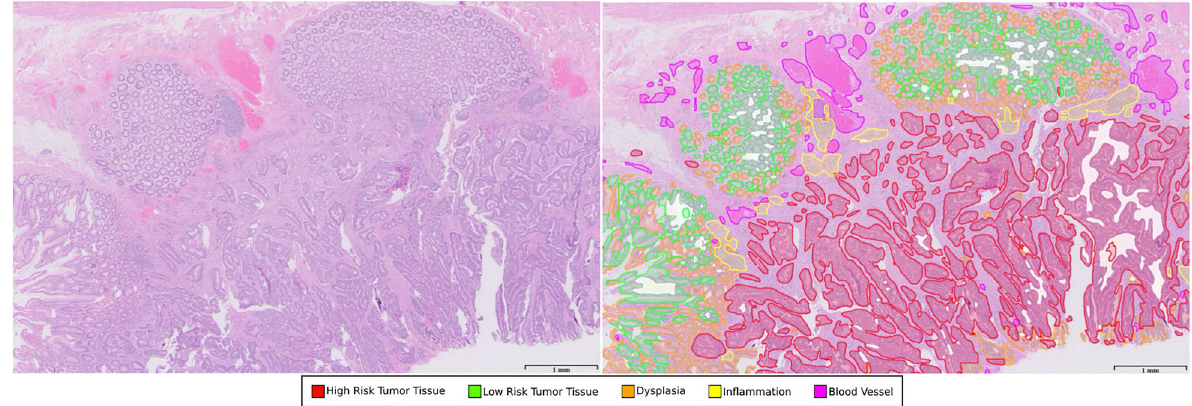
Figure 1. A sample analysis on a whole slide image (WSI). Left: original image. Right: the segmentation model highlighted regions of the WSI as (1) likely benign or normal (green), (2) likely dysplastic (orange), and (3) likely malignant (red). The AI model also segmented blood vessels (pink) and inflammation (yellow), and these segmentations were taken into account for slide labeling.